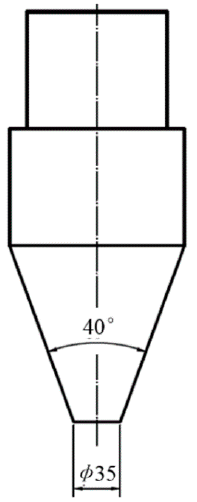
Figure 3. Conical mandrel dimensions in the expansion test (unit: mm).